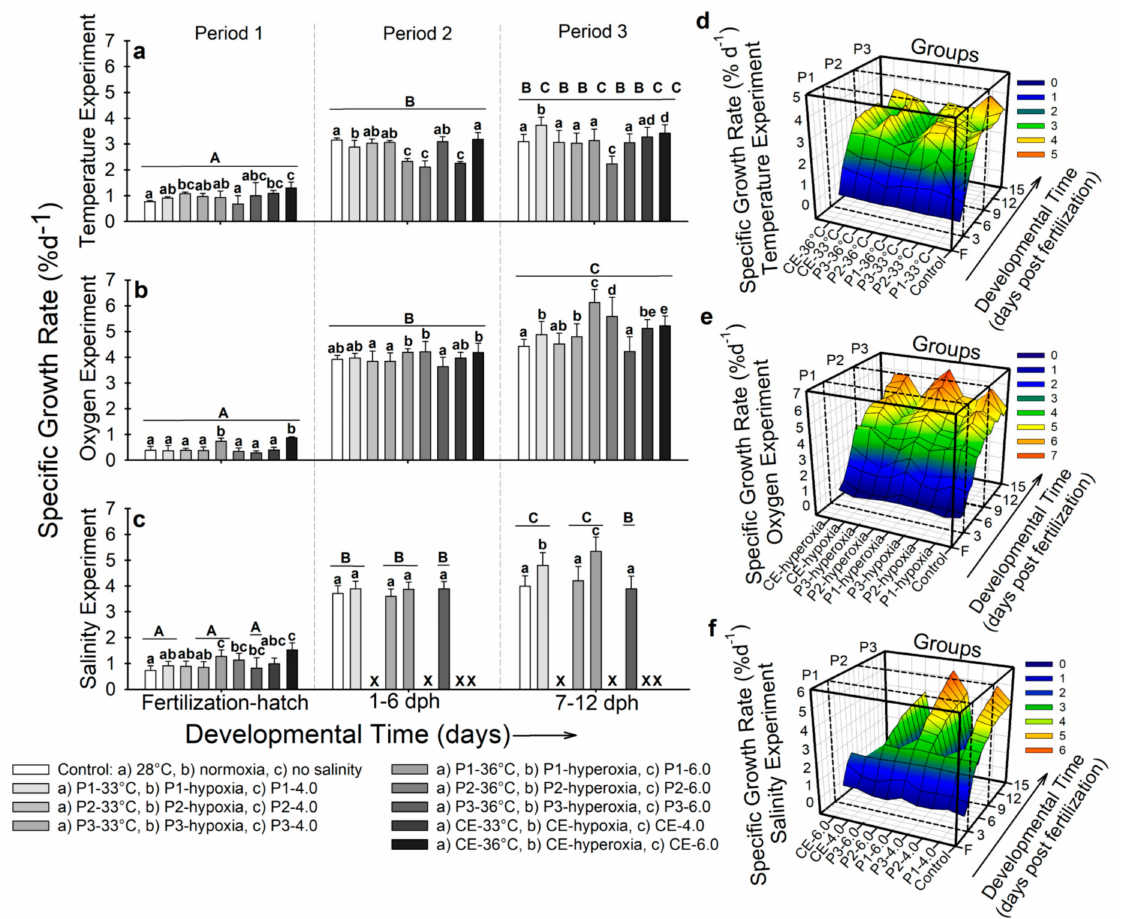
Figure 4. Specific growth rate (SGR) of Atractosteus tropicus . ( a ) Temperature, ( b ) air saturation, and ( c ) salinity experiments at the end of each developmental period. Means ± SEM are presented. Lowercase letters represent differences between experimental groups from each developmental period ( p < 0.001). Capital letters indicate differences within developmental time for each experimental group ( p < 0.001). Panels ( d – f ) show the relation between development, treatments, and effect on the specific growth rate of the fish in the whole experiments for temperature, air saturation, and salinity, respectively. Control conditions: 28 ◦ C, 0.0 ppt of salinity, normoxia (95% air saturation); treatments 1: 33 ◦ C, hypoxia (~30% air saturation), or 4.0 ppt of salinity respectively to each experiment; treatments 2 (independently for each experiment): 36 ◦ C, hyperoxia (117% air saturation), or 6.0 ppt of salinity respectively to each experiment. Black crosses (X) in the salinity experiment represent groups where all fish died. n = 20 for each